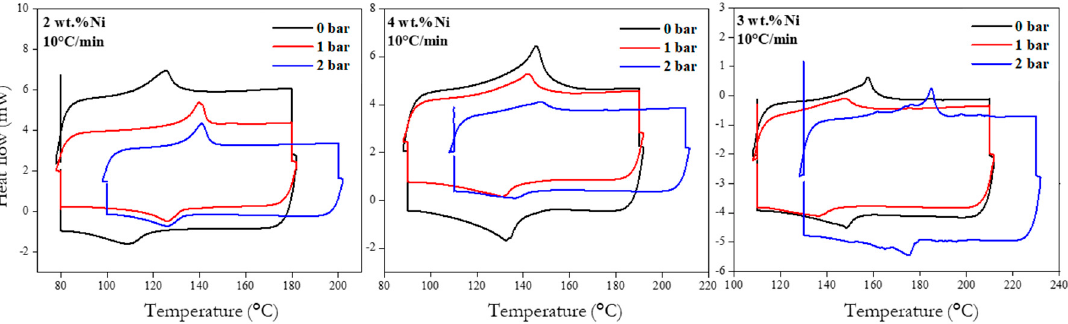
Figure 9. DSC curves obtained at 10 °C·min − 1 for samples fabricated with the indicated content Ni at the relative pressure of 2 bar (blue line), 1 bar (red line), and 0 bar (black line). Table 3. Summary of transformation temperatures, enthalpies, and temperature hysteresis determined from the DCS analysis of all the samples.